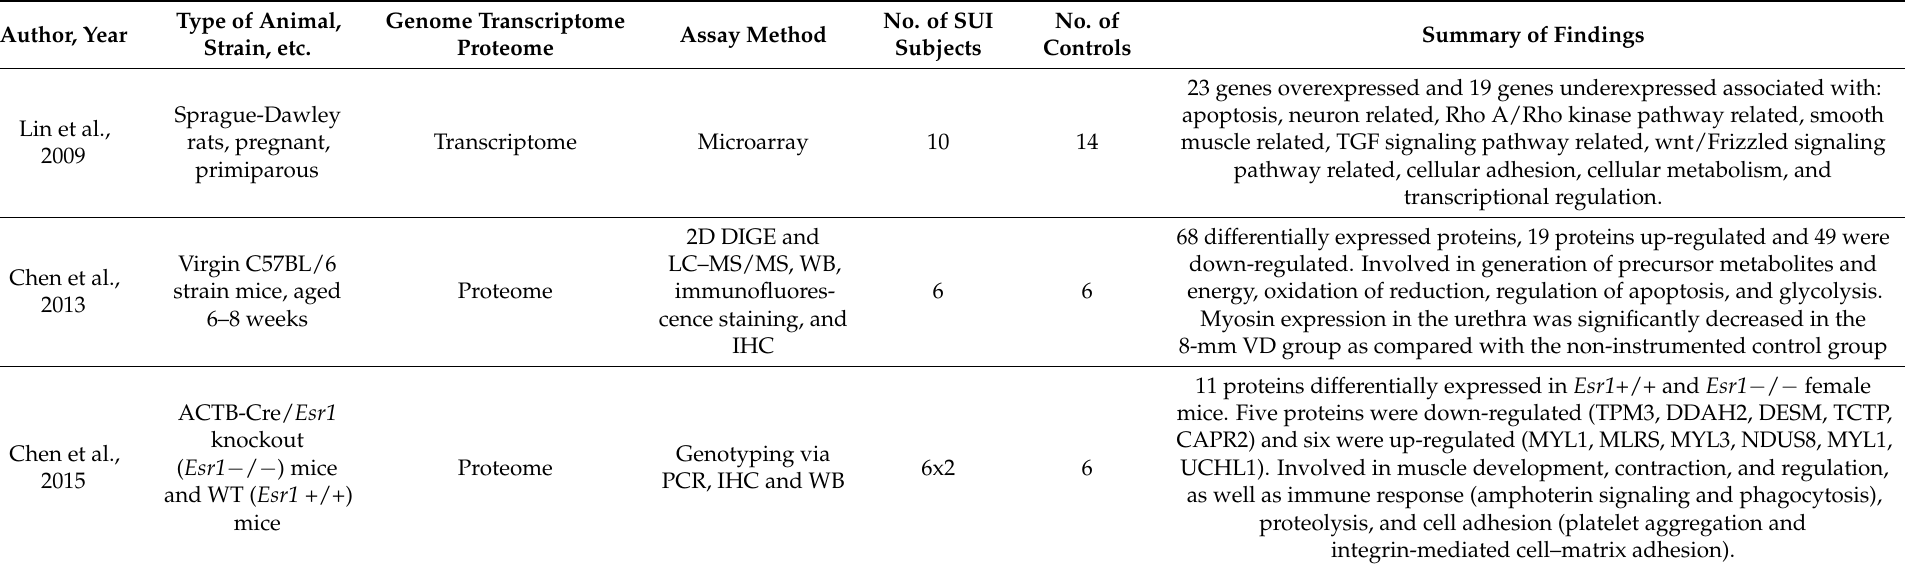
Table 2. Animal studies with hypothesis-free